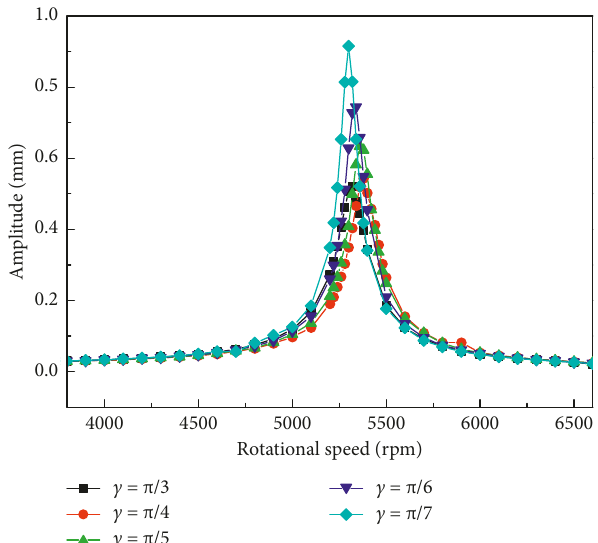
Figure 8: The influence of contact angles between shrouds on the vibration characteristics.